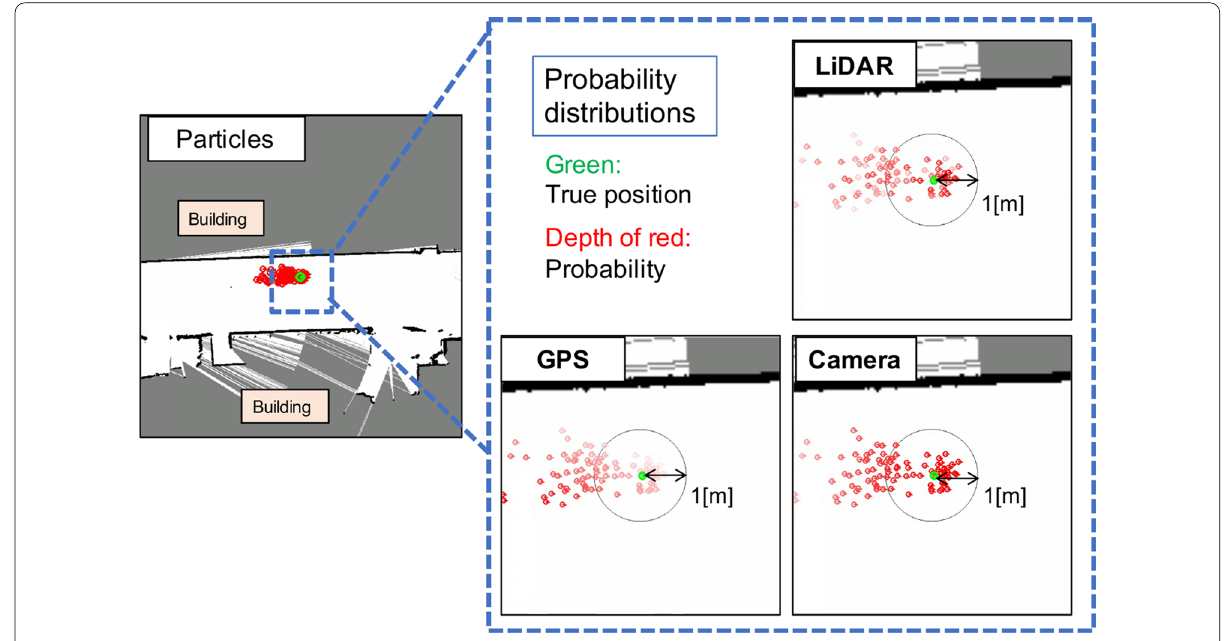
Fig. 8 Probability distributions at 330 s in Fig. 6